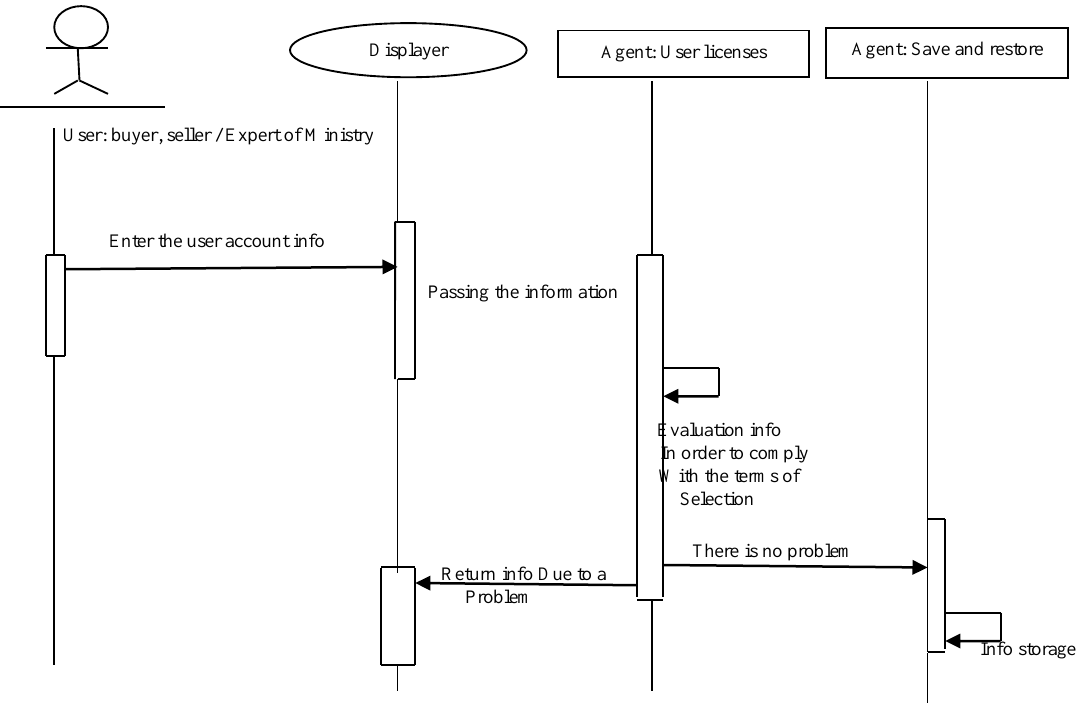
Figure 7. The interaction model of user licenses role within the scope of